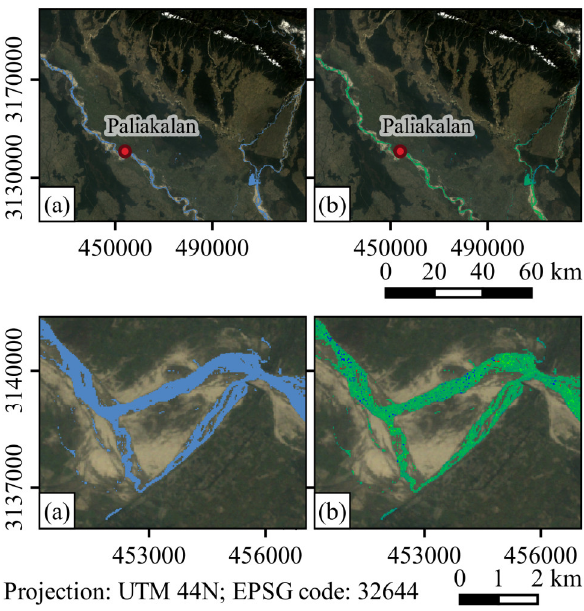
Figure 5. (a) River body mapped based NDWI 3 , (b) modeled EC based 3 rd degree polynomial multiple regression analysis for Paliakalan station surroundings,